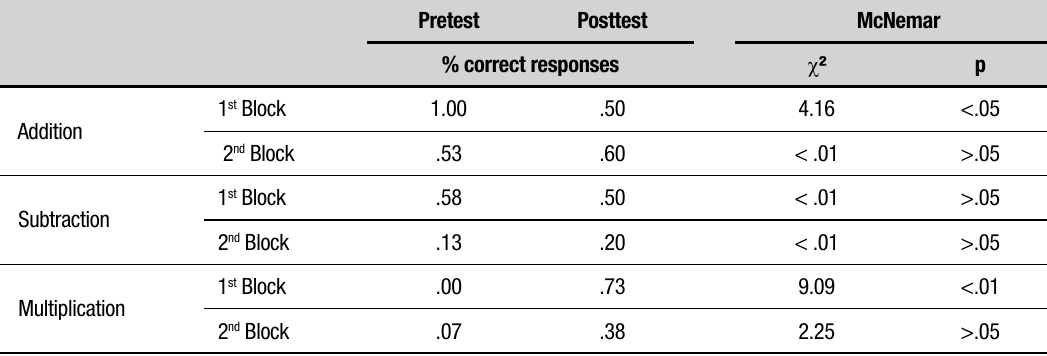
table 2. GA’s accuracy on the pretest and posttest for the SCT.